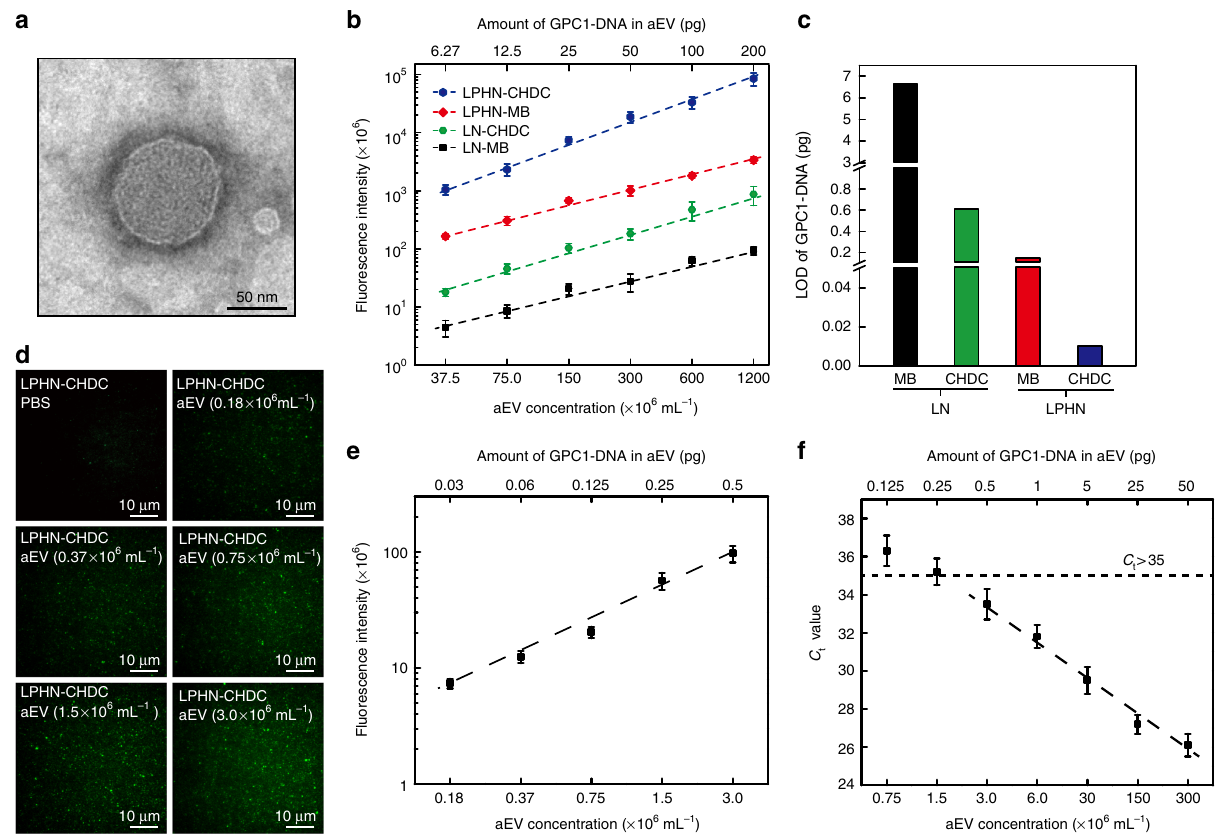
Fig. 2 Arti fi cial EV works as a standard. a Transmission electron microscopy (TEM) micrograph of arti fi cial EV (aEV). b Calibration curves for fl uorescence intensity of GPC1 ssDNA oligo (GPC1-DNA) expression in aEVs using lipoplex nanoparticles containing molecular beacon (LN – MB), lipoplex nanoparticles containing catalyzed hairpin DNA circuit (LN – CHDC), lipid-polymer hybrid nanoparticles containing molecular beacon (LPHN – MB), and lipid-polymer hybrid nanoparticles containing catalyzed hairpin DNA circuit (LPHN – CHDC) individually vs. aEV concentration (37.5, 75.0, 150, 300, 600, and 1200 × 10 6 mL − 1 ) (bottom x -axis) or amount of GPC1-DNA in aEV (6.27, 12.5, 25.0, 50.0, 100, and 200 pg) (upper x -axis). c Linear scale comparison of limit of detection (LOD) among LN – MB, LN – CHDC, LPHN – MB, and LPHN – CHDC. d Representative TIRF images of GPC1-DNA expression in varied extremely low concentrations of aEVs (0.18, 0.37, 0.75, 1.5, and 3.0 × 10 6 mL − 1 ) by using LPHN – CHDC. e Calibration curve for fl uorescence intensity of GPC1-DNA expression in aEVs using LPHN – CHDC vs. low concentration of aEV (0.18, 0.37, 0.75, 1.5, and 3.0 × 10 6 mL − 1 ) (bottom x -axis) or low amount of GPC1-DNA in aEV (0.03, 0.06, 0.125, 0.25, and 0.5 pg) (upper x -axis). f Standard curve of GPC1-DNA expressed in aEVs as the DNA quantity per reaction tube of RT-PCR from 0.125 to 50 pg by serial dilutions, respectively. Data represent mean ± s.d., n = 3, three technical